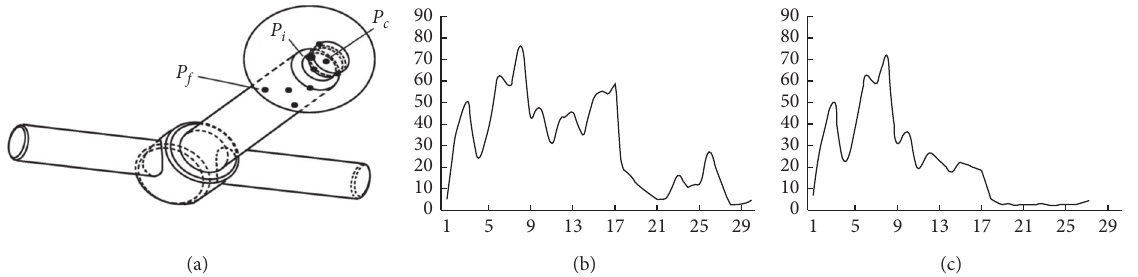
Figure 7: The perspective distance-angle shape distribution of the garden landscape in the 3D CAD model area. (a) An example of the neighborhood of the model sampling point. (b) Before Gaussian weighting ( σ � 0 . 33). (c) After Gaussian weighting ( σ �